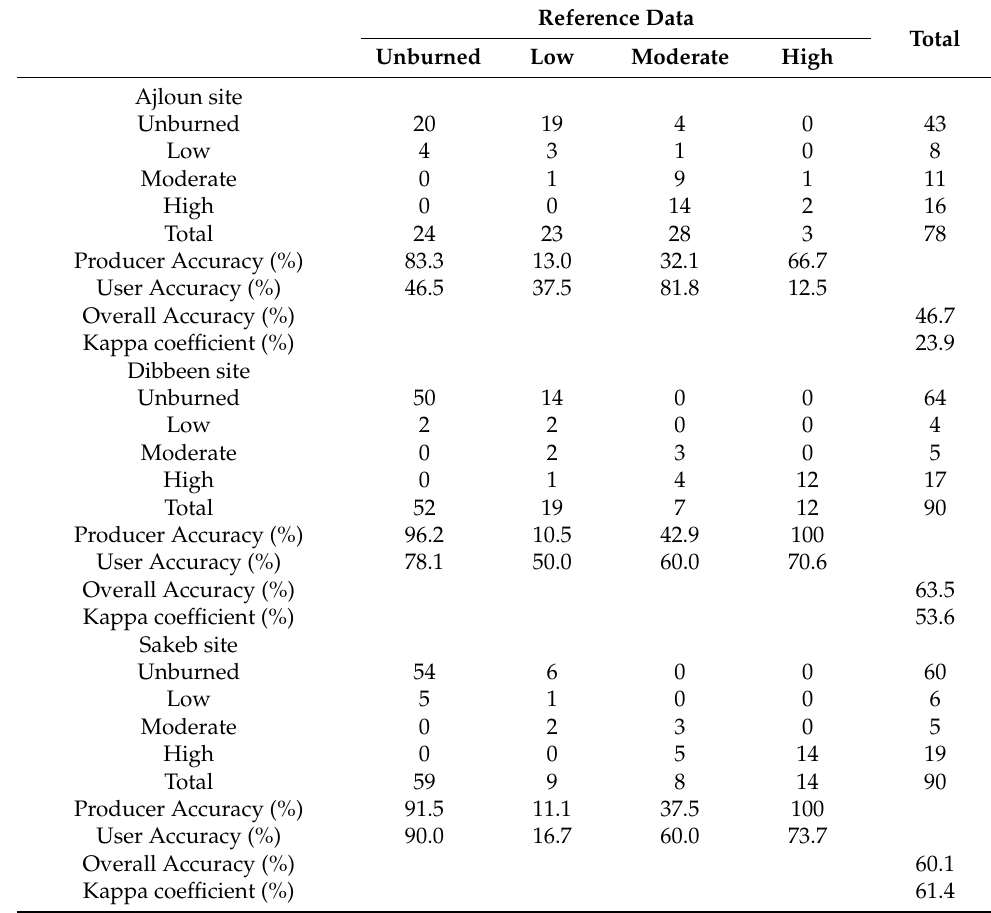
Table 5. Confusion matrix and accuracy assessment of burn severity levels derived using Landsat differenced Normalized Burn Ratio (dNBR), for Ajloun (2020), Dibbeen (2016) and Sakeb (2003)